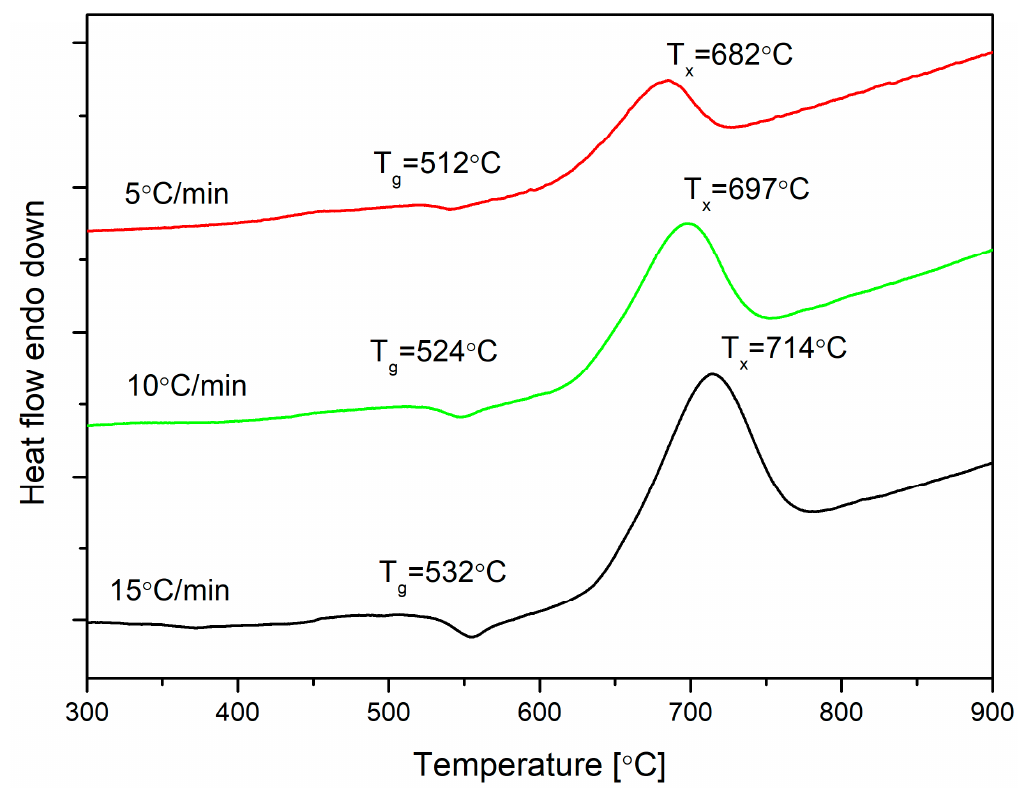
Figure 1. Differential Scanning Calorimetry (DSC) curves recorded for 45S5 Bioglass ® at heating rates of β = 5, 10, and 15°C/min. Table 1. Crystallization peak temperatures of 45S5 Bioglass ® for different heating rates.